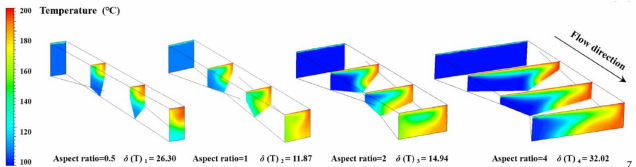
Figure 8. Temperature distributions in the single torsion channels.